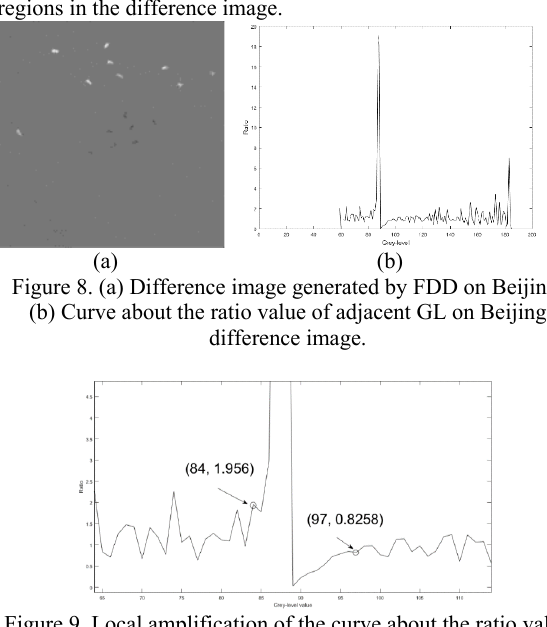
Figure 9. Local amplification of the curve about the ratio value of adjacent GL on Beijing difference